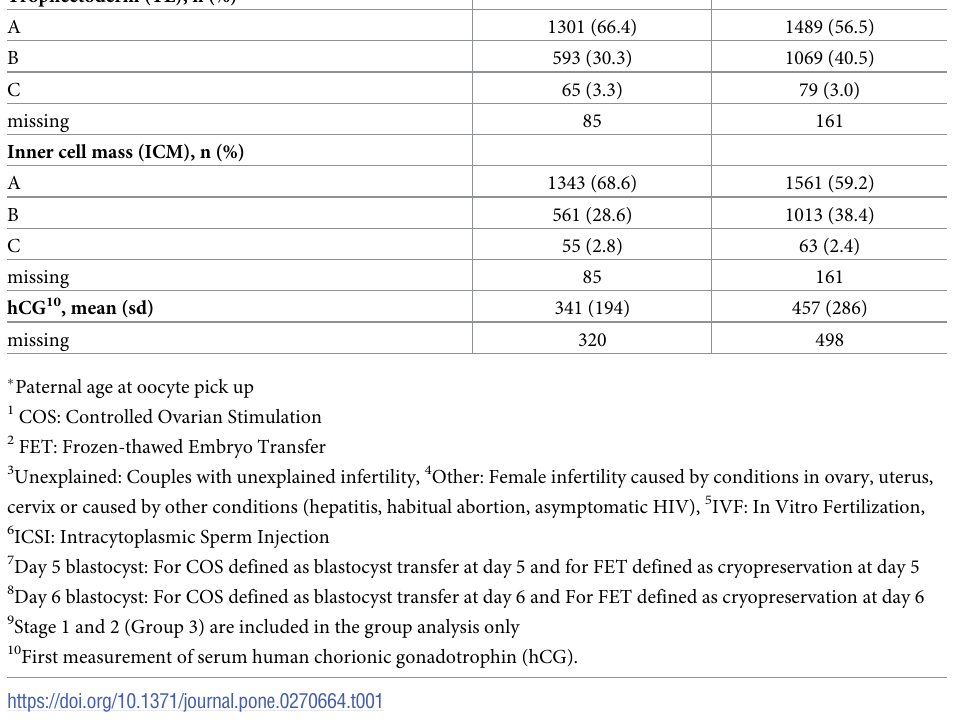
Table). Further stratification on paternal age can be seen in S1 Table. The squared correlation coefficient between women’s- and men’s age was R 2 = 0.35 (S2